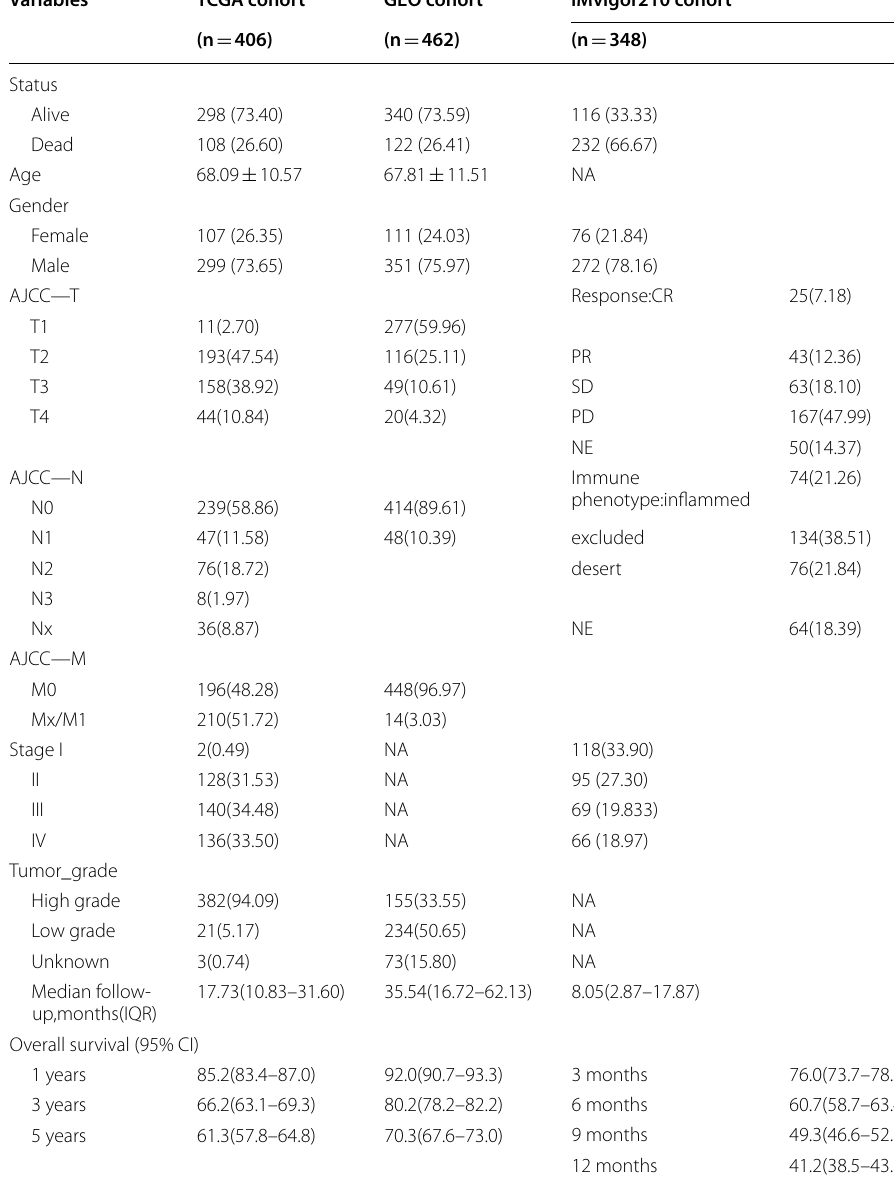
Table 1 Clinical features of all eligible 1216 BCa patients from TCGA, GEO and IMvigor210